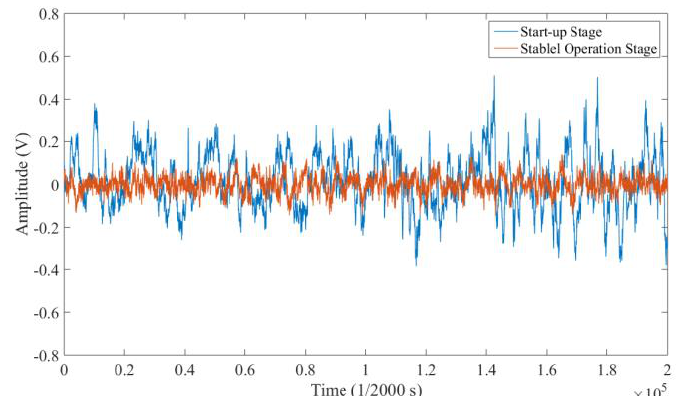
Figure 12. The raw signal in the start-up stage and the stable operation stage.